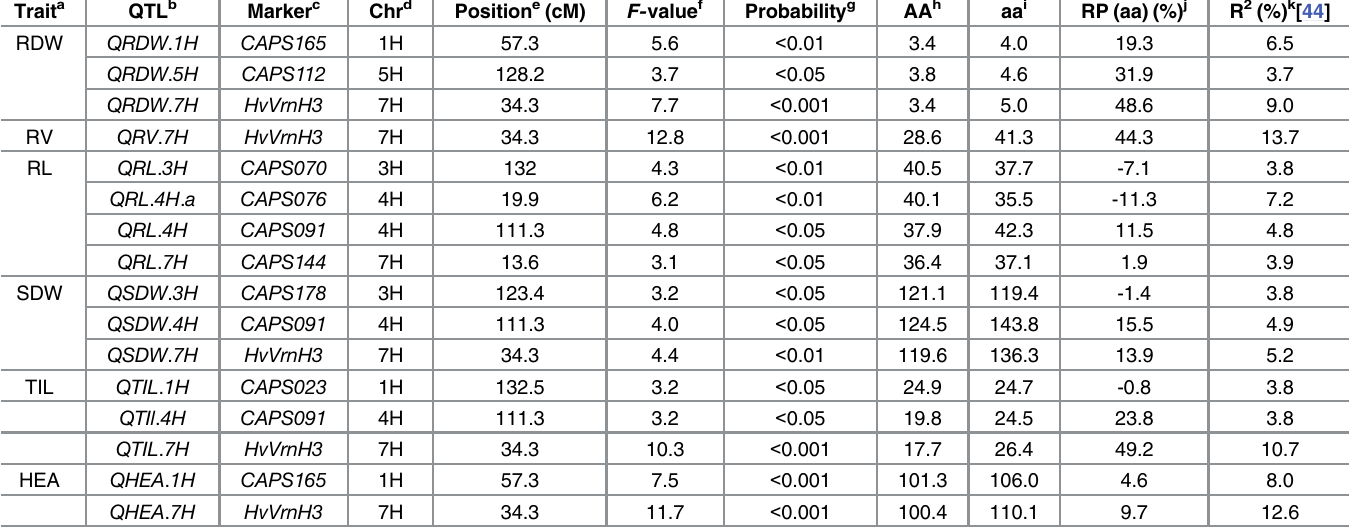
Table 3. List of detected QTL for the root, shoot and heading traits in the F2 population of a cross between spring barley cultivar Cheri and wild accession ICB181160. Trait